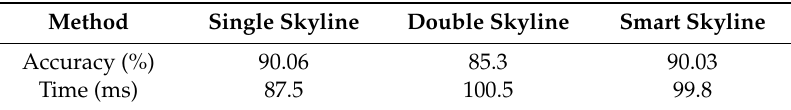
Table 29. SKY–SVM on the real